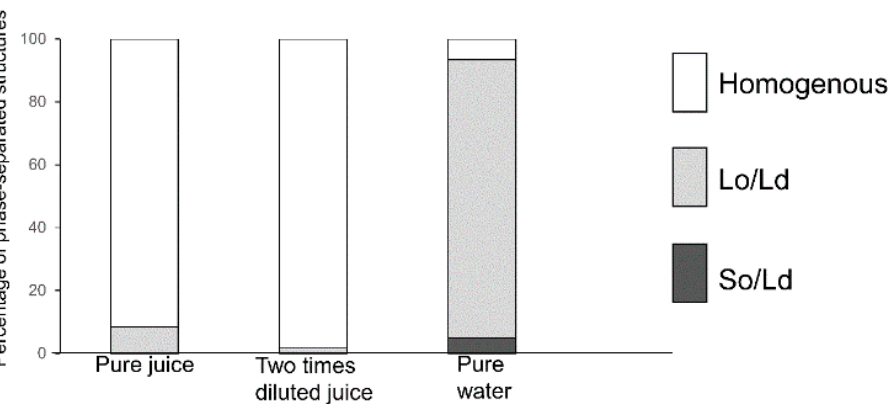
Figure 7. The percentage of phase-separated structures; 1,2-Dioleoyl-sn-glycero-3-phosphocholine (DOPC)/1,2-dipalmitoyl-sn-glycero-3-phosphocholine (DPPC)/cholesterol (Chol) with several concentrations of procyanidin b2 (PB2) containing pure juice, two times diluted juice, and pure water are represented. White, bright gray, and dark gray bars denote homogenous, Lo/Ld, and So/Ld phase,